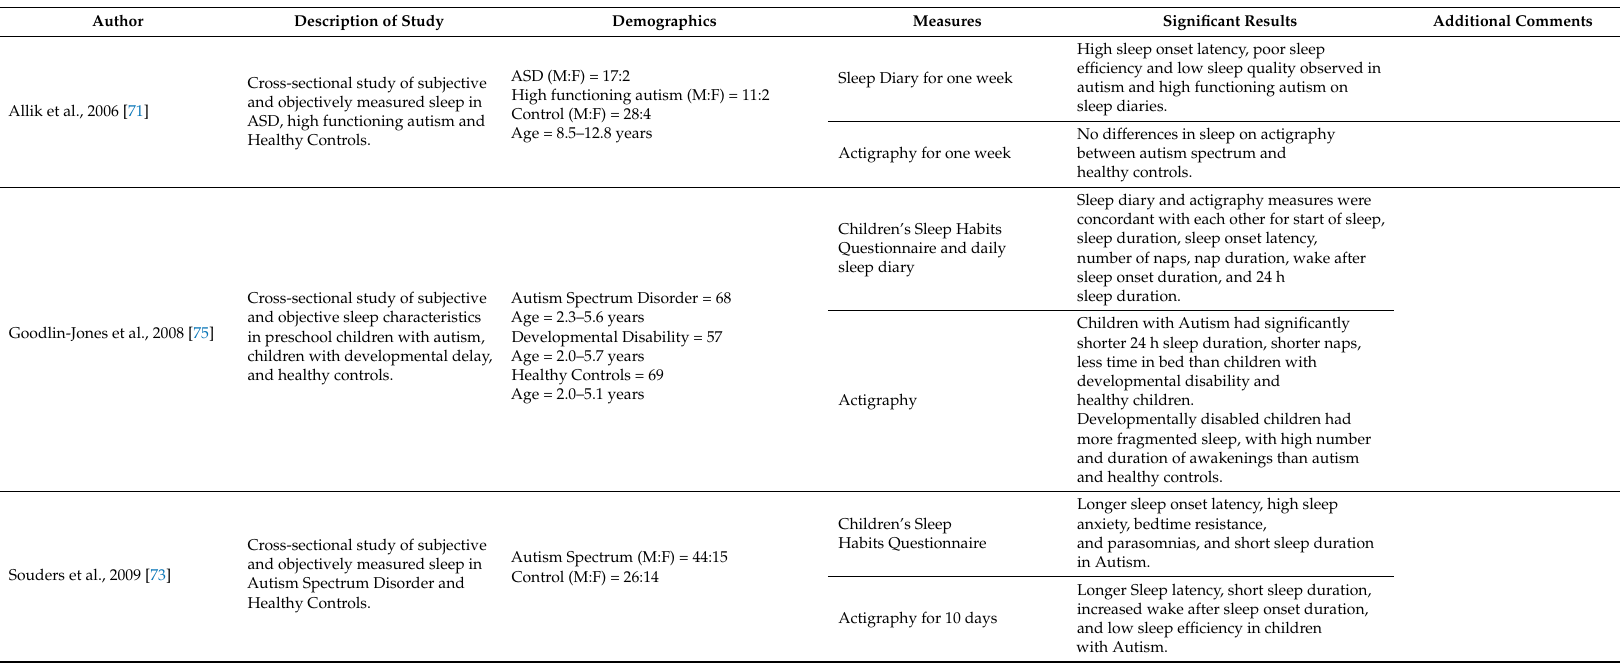
Table A3. Subjective and objective sleep findings in autism spectrum disorders